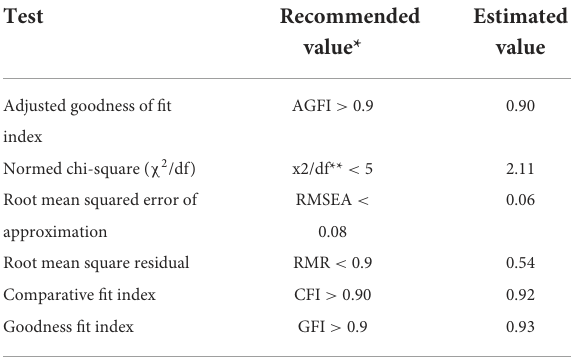
on farmers during the COVID-19 pandemic (39). Phillipson TABLE 8 The goodness-of-fit indicators for the model derived from farmers’ vulnerability to